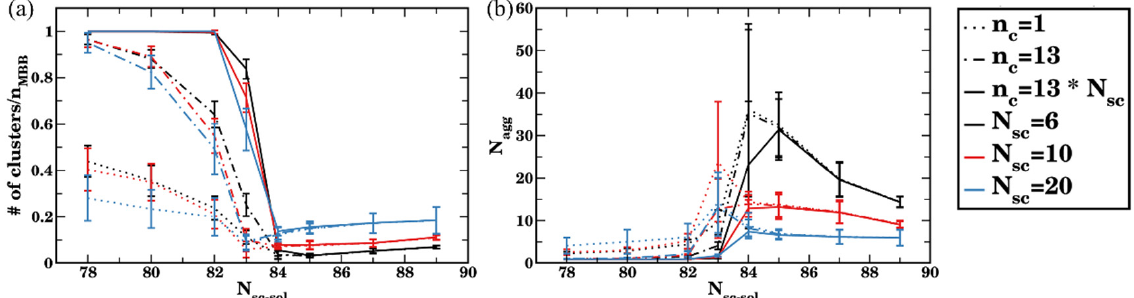
Figure 11. ( a ) Number of clusters scaled by total number of bottlebrushes and ( b ) average aggregation number as a function of solvent quality. Black, red, and blue curves correspond to the side chain length N sc = 6, 10, and 20. Dotted, dash-dotted, and solid lines of the same color represent the minimum cutoff value used to identify clusters (1, 13, and 13 multiplied by N sc , respectively).